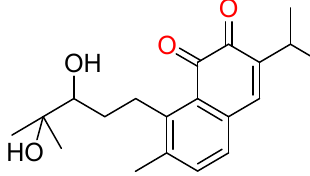
Figure 11. Salvicine.